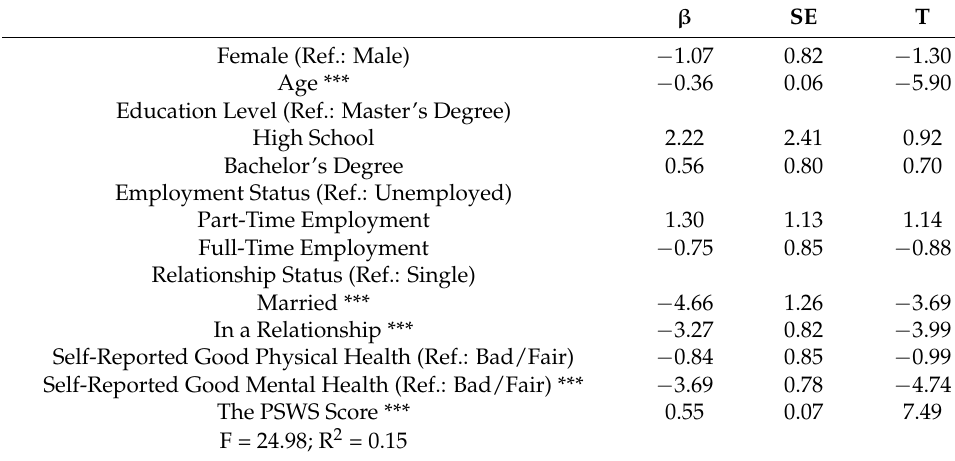
Table 5. Multiple regression model of social interaction anxiety, measured on the Chinese version of the Social Interaction Anxiety Scale